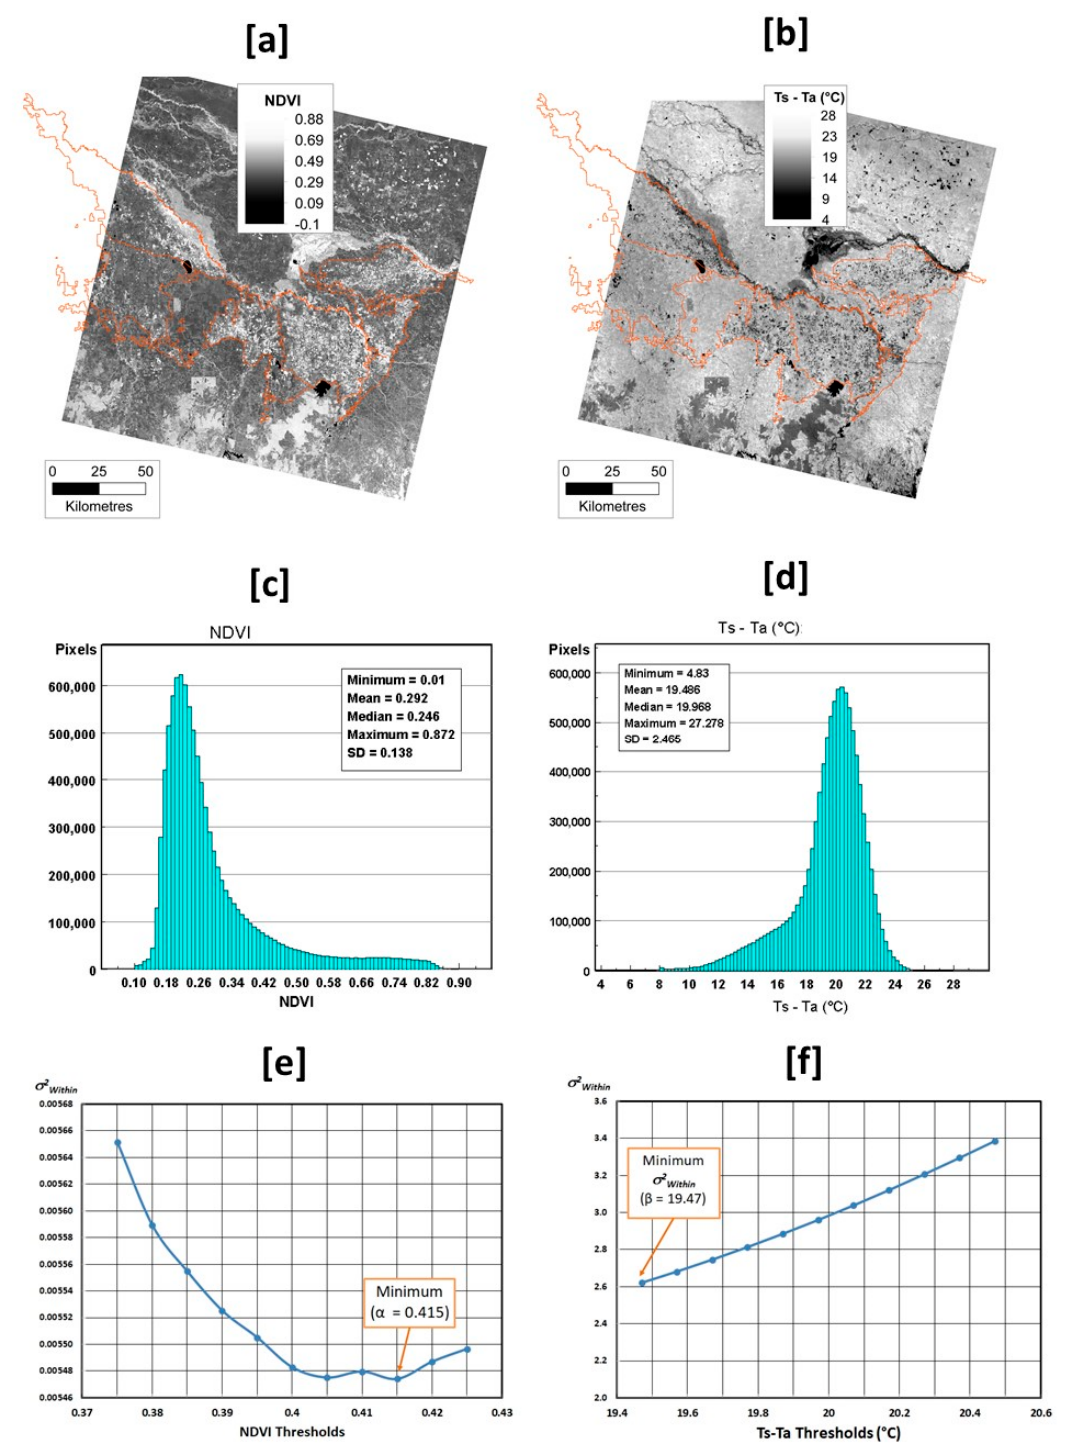
Figure 3. An example of thresholding process based on the Landsat ‐ 8 image acquired on 19 January 2019 around 11:09 a.m. (local time), which covers a major central part of the study area. ( a ) normalized difference vegetation index (NDVI) map; ( b ) Map showing Ts ‐ Ta at pixel level; ( c ) Histogram of NDVI; ( d ) Histogram of Ts ‐ Ta; ( e ) Iteration of within ‐ class variance for the NDVI threshold; and ( f ) Iteration of within ‐ class variance for Ts ‐ Ta threshold.